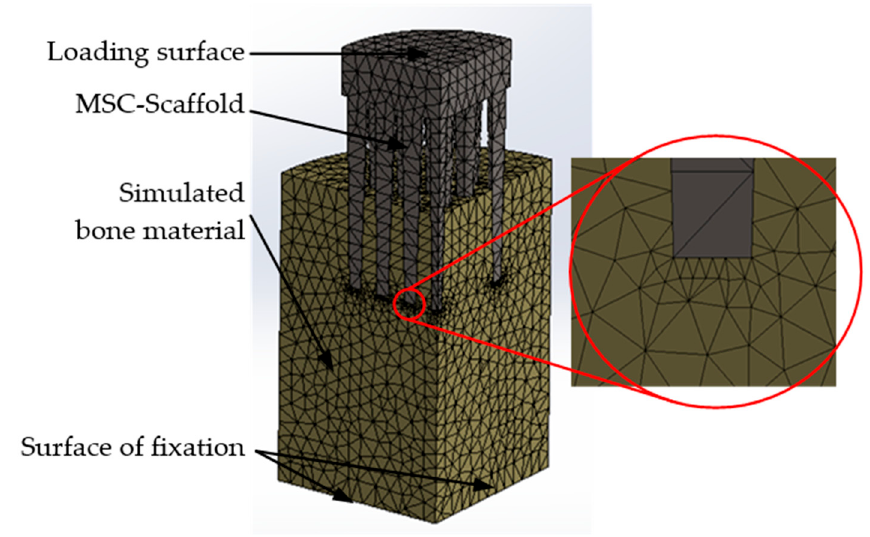
Figure 3. Simulation model of the MSC-Scaffold prototype embedded in the periarticular bone with the generated FE mesh. The surfaces of FE fixation and the loading surface are marked with arrows.